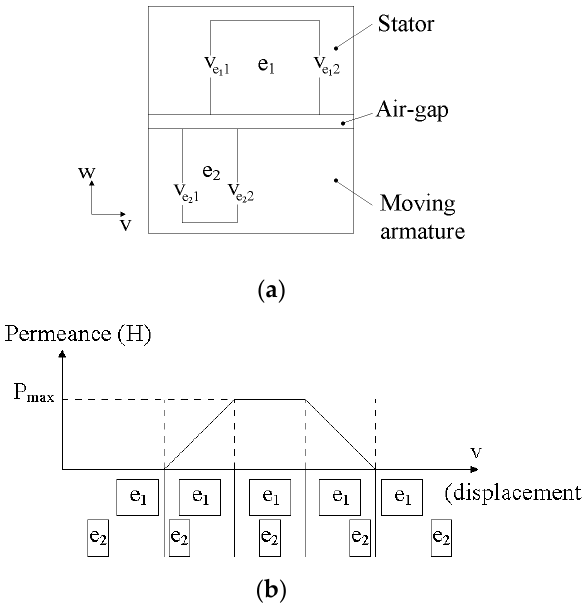
Figure 24. Air-gap permeance (reluctance) calculation.